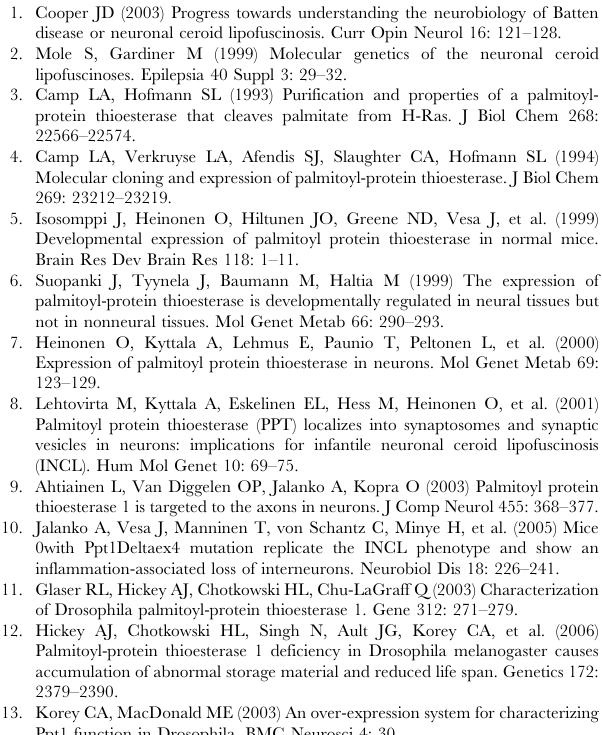
Figure S2 Western blot using affinity-purified Ppt1 polyclonal antibody (generated against the C-terminus) of S2 cell lysate,